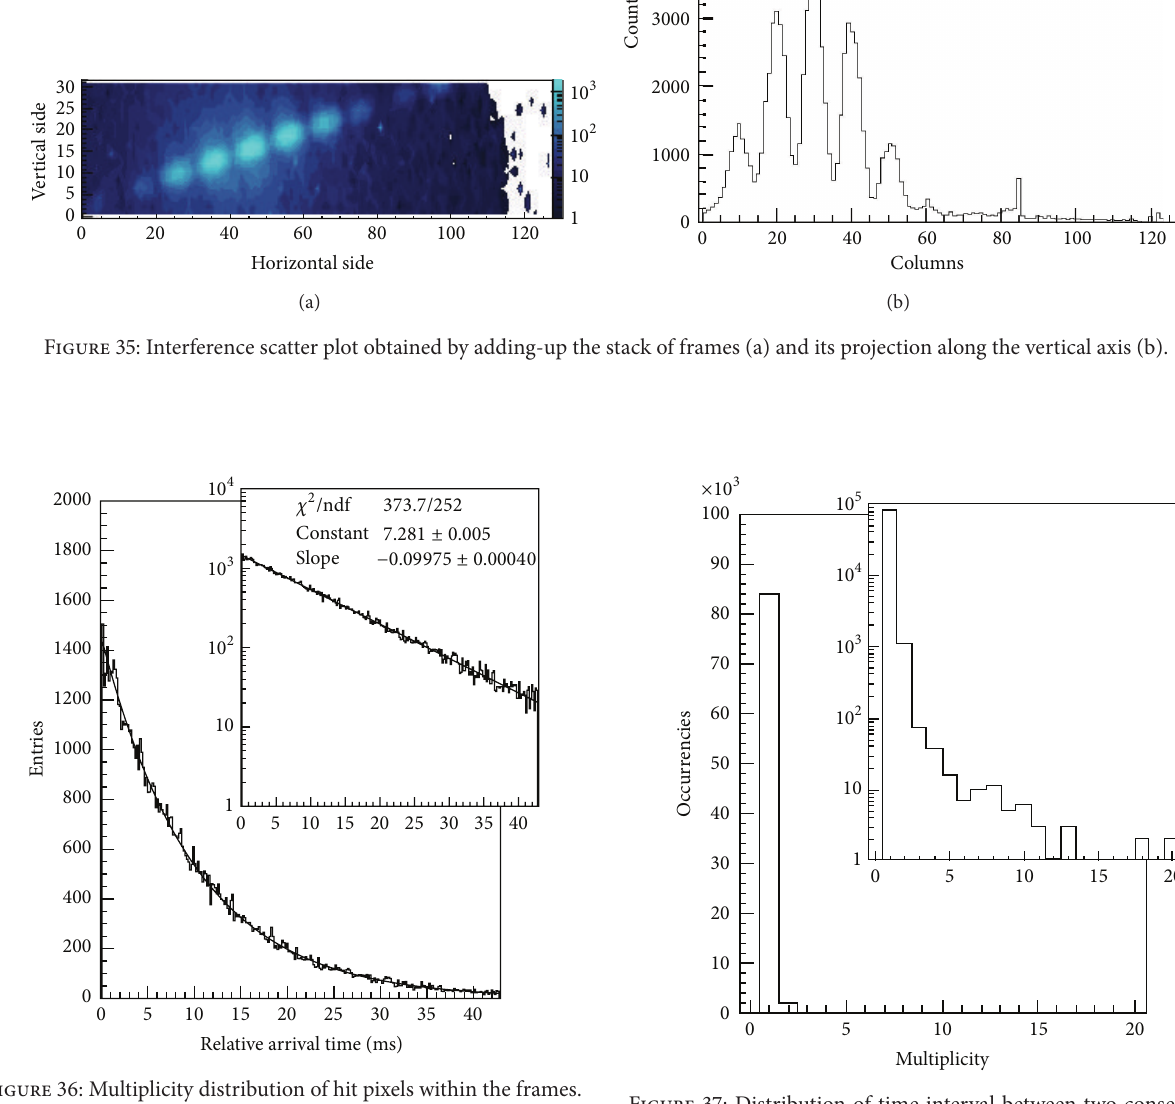
Figure 37: Distribution of time interval between two consecutive nonempty